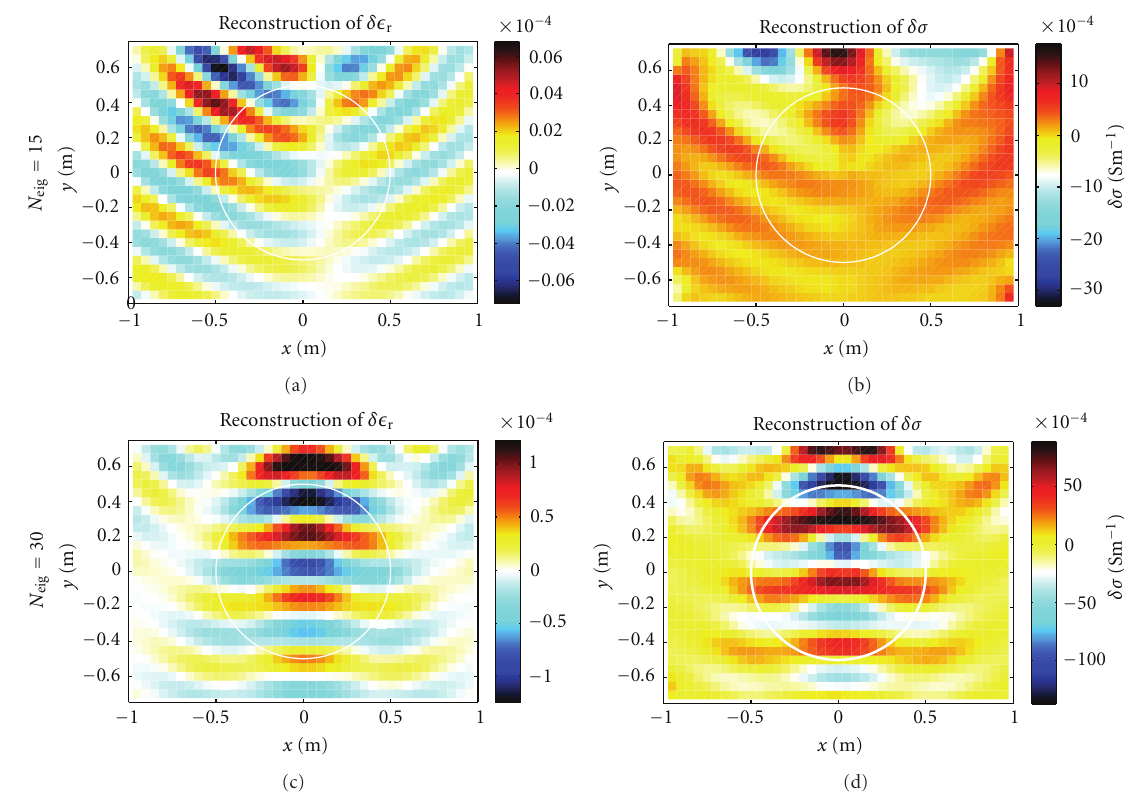
Figure 2: Reconstruction of δ (cid:2) r and δσ in a straightforward data fusion without statistically based weighting (the weighting is assumed to be uniform with R (2) /R (1) = 1). The upper and lower rows are obtained by using N eig = 15 and N eig = 30 eigenvalues,